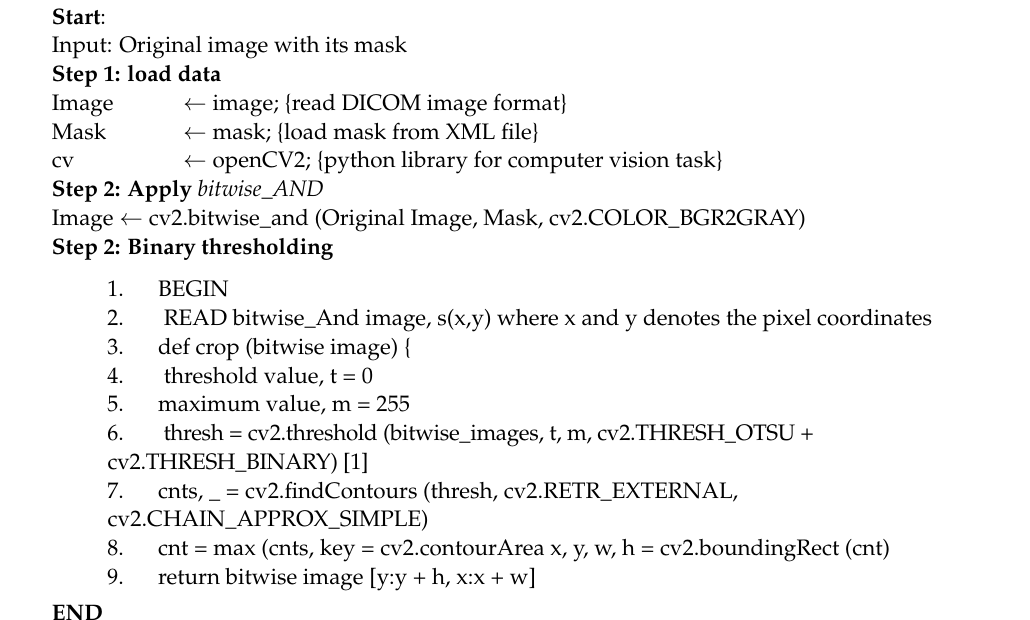
Algorithm 1: Patch Image Extraction via Image Preprocessing Approach